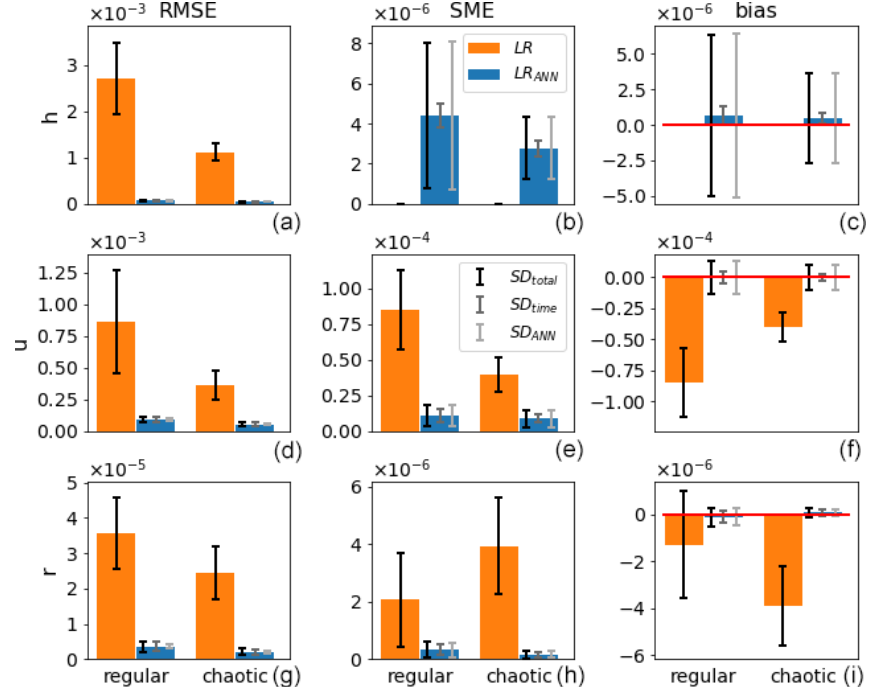
Figure 4. Mean (bars) and standard deviations SD total , SD time , and SD ANN (error bars; from dark to light, respectively) of the RMSE (a, d, g) , SME (b, e, h) , and bias (c, f, i) of ANN corrected (blue) and uncorrected (orange) single time step predictions of the validation data with respect to the model truth for the regular and chaotic cases ( y axis) and for the variables h , u , and r (from top to